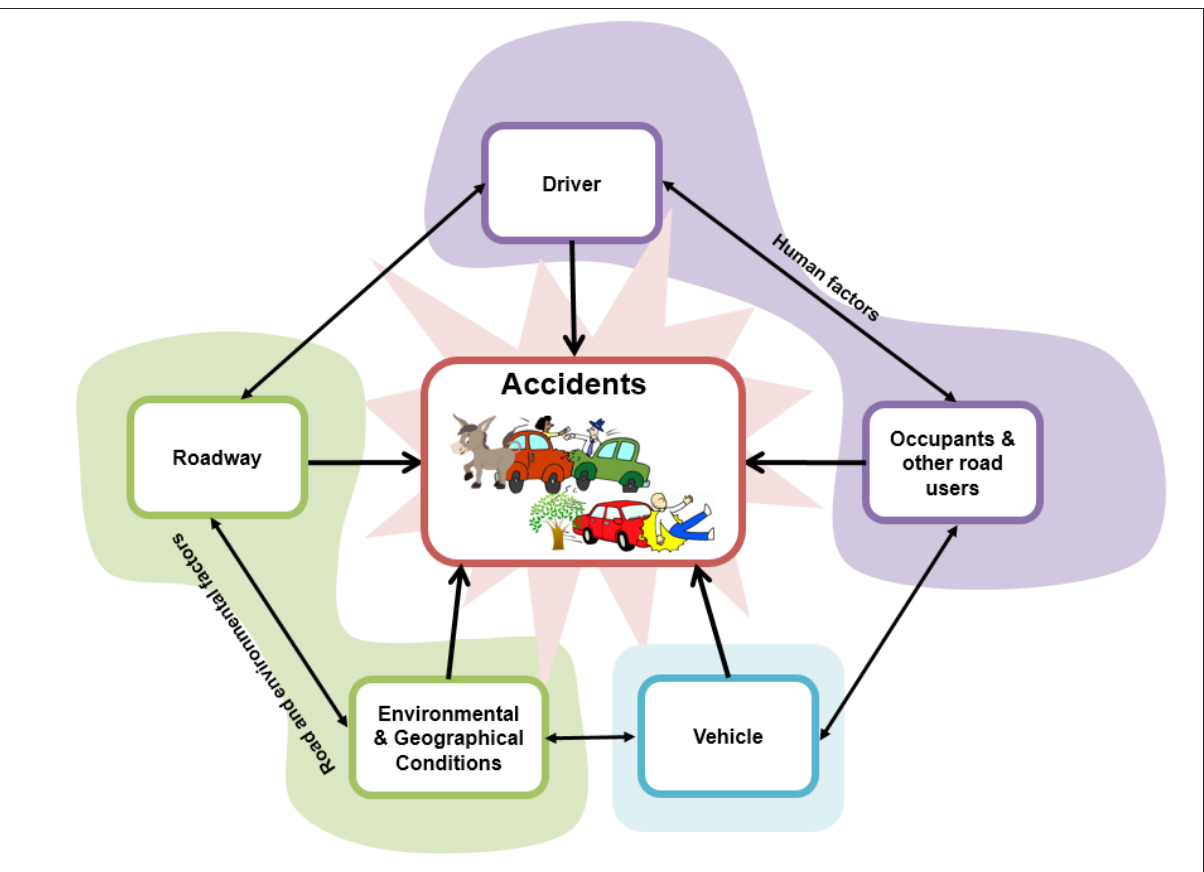
Figure 1: Five factors identified 6 to cause or interact to cause road